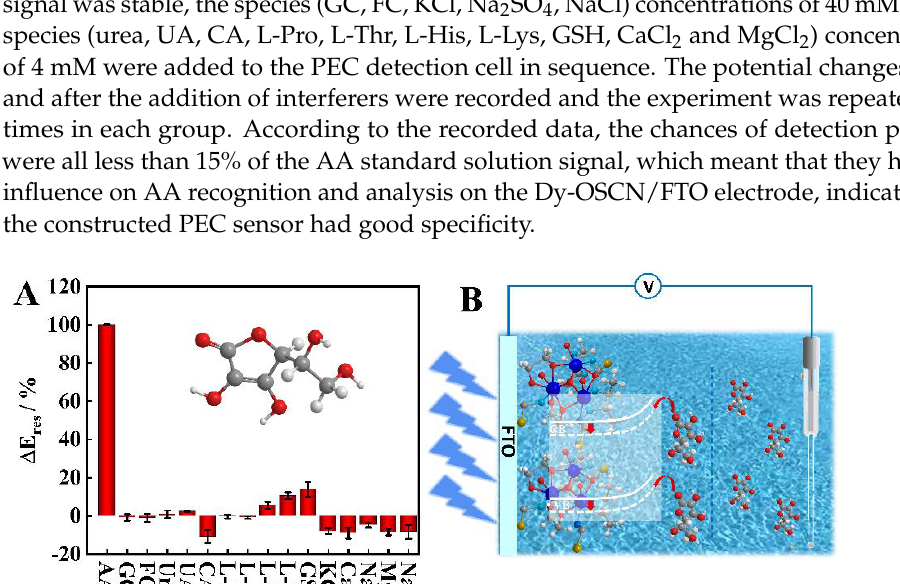
Figure 5. ( A ) Selectivity of the PEC sensor to AA interferes including GC, FC, urea, UA, CA, L-Pro, L-Thr, L-His, L-Lys, GSH, KCl, CaCl 2 , NaCl, MgCl 2 and Na 2 SO 4 ; ( B ) diagram of possible detection mechanism of AA on enzyme-free Dy-OSCN/FTO PEC sensor.